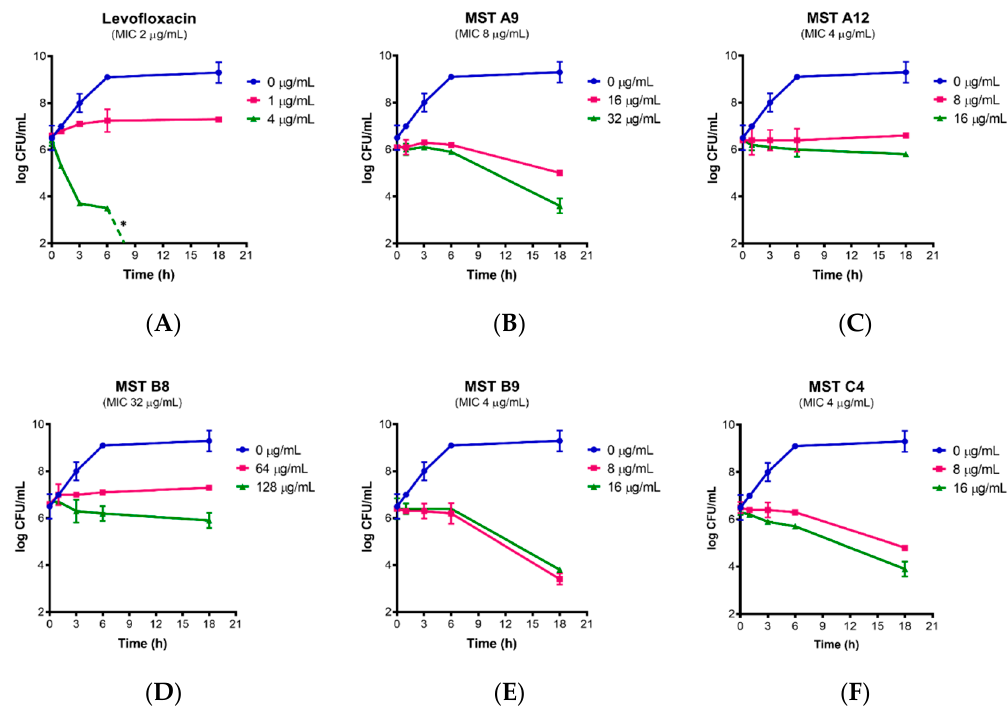
Figure 3. Time-kill curves for MST compounds. Viable cell counts were performed for ( A ) MRSA in the absence of any levofloxacin (blue line) and in the presence of levofloxacin at bacteriostatic (1 µ g / mL) and bactericidal (4 µ g / mL) concentrations; ( B – F ) in the presence of no compound (blue line), 2 × MIC of the compounds (pink line) and 4 × MIC of the compounds (green line). The results are representative of three independent experiments performed with di ff erent batches of cells and are presented as mean log CFU / mL ± SEM. The asterisk (*) represents viable cell counts below 1 × 10 3 CFU /